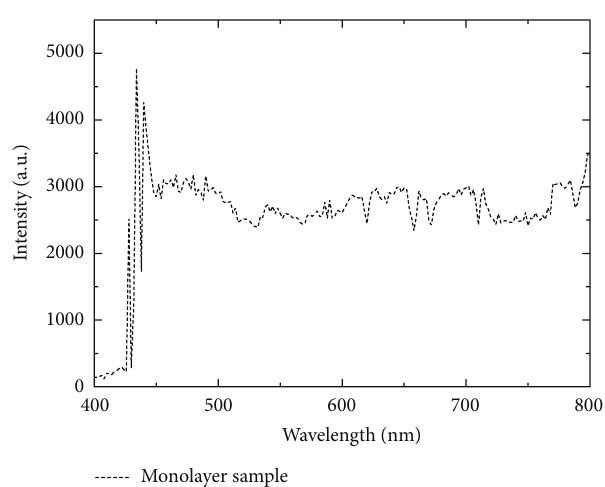
Figure 8: Photoluminescence emission spectra of monolayer sam- ple at 300 nm.